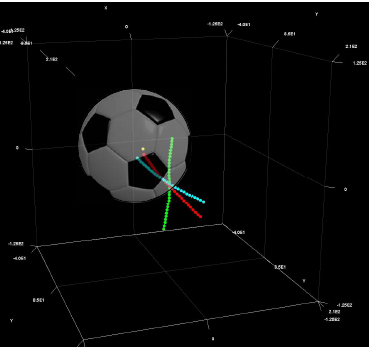
Figure 6. The POF trajectory of three trial straight, curve and knuckle. They are showed in mean coordinate value of POF in each trial. The light blue dots shows straight trail. The green dots shows curve trial. The red dots shows knuckle trial.